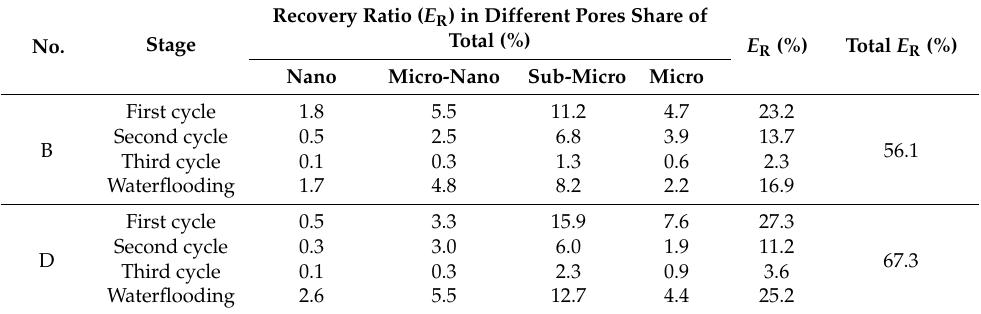
Table 3. Recovery ratio for the cores and their different pores in the huff-n-puff experiment.